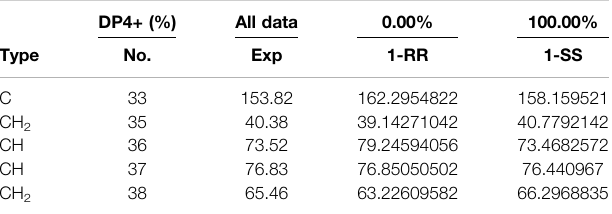
TABLE 3| Comparison ofcalculated 13 CNMRchemicalshifts withexperimentally observed shifts for 1 . DP4+ (%) All data 0.00%